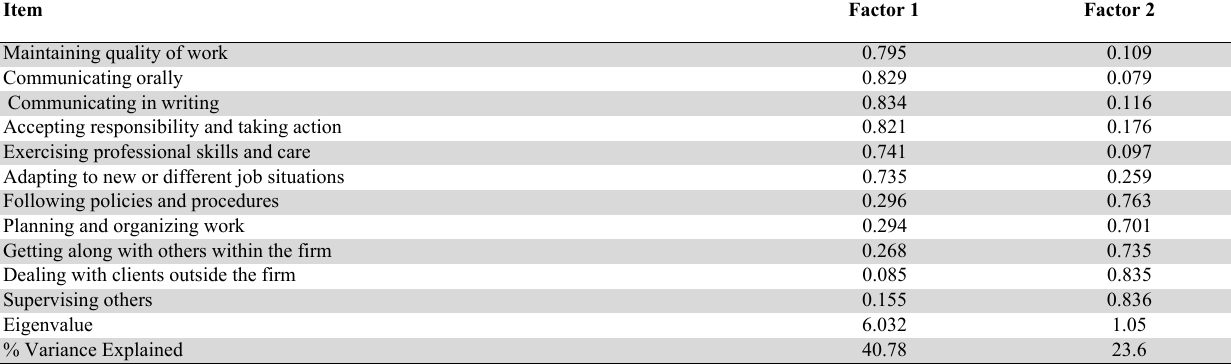
PCA. Performance at work (after oblique